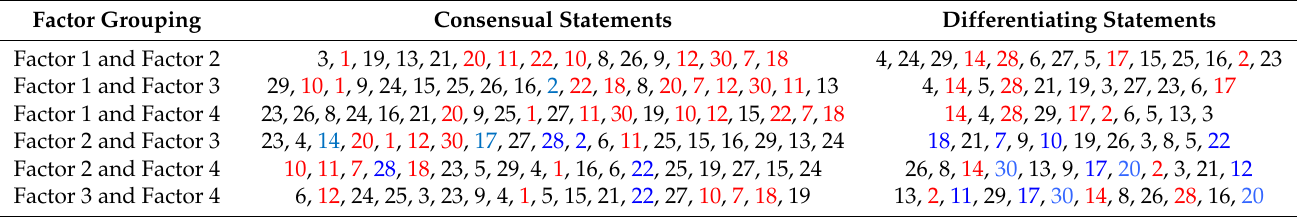
Table 6. Consensual and differentiating statements for each group of